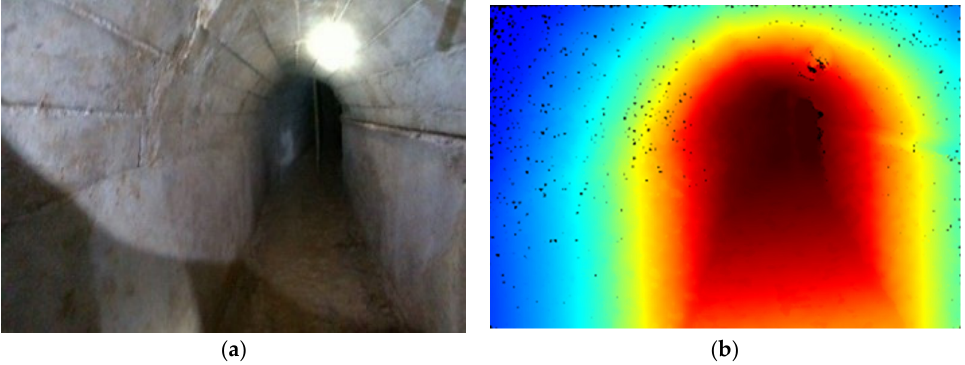
Figure 2. Original image of RGB-D camera. ( a ) Color image; ( b ) Depth image.